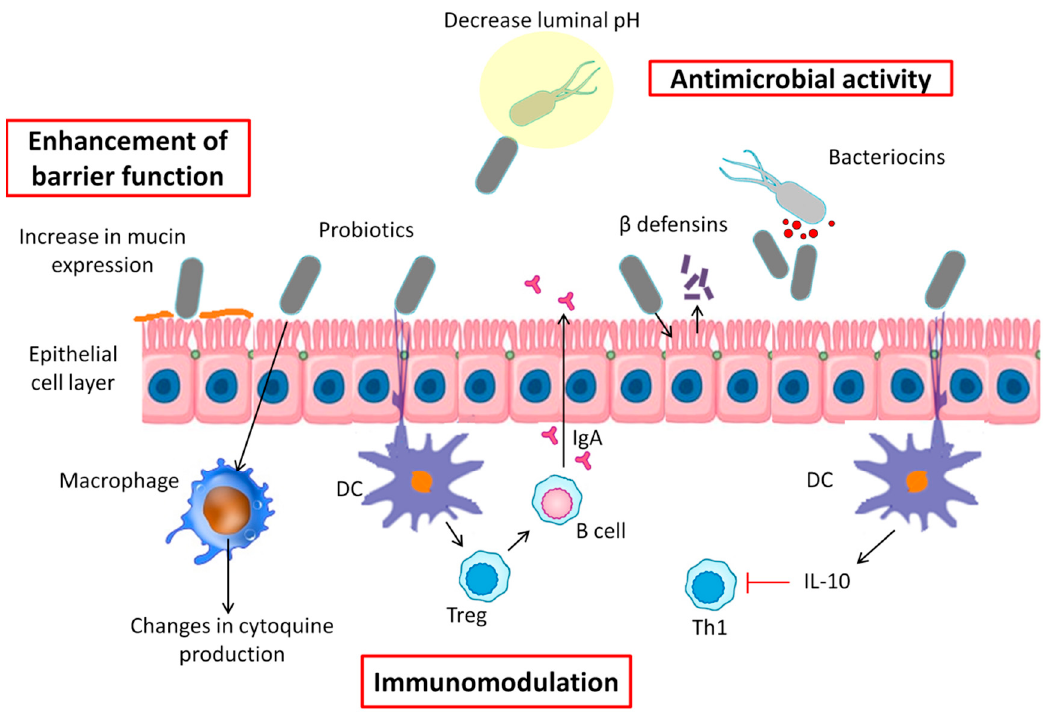
Figure 1. A schematic diagram about potential mechanisms whereby probiotic bacteria might perform within the intestine. These mechanisms include antagonistic effects on various microorganisms, competitive adherence to the mucosa and epithelium (antimicrobial activity), increased mucus production and enhanced barrier integrity (enhancement of barrier function), and modulation of the human immune system (immunomodulation).